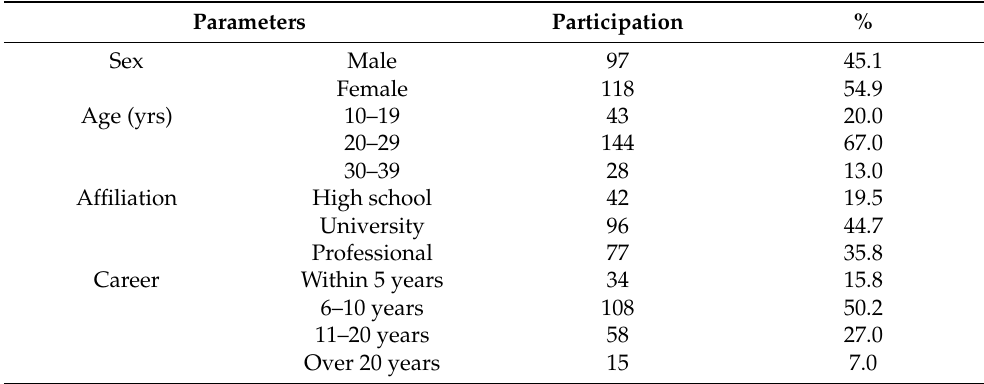
Table 1. General characteristics of participants ( n =